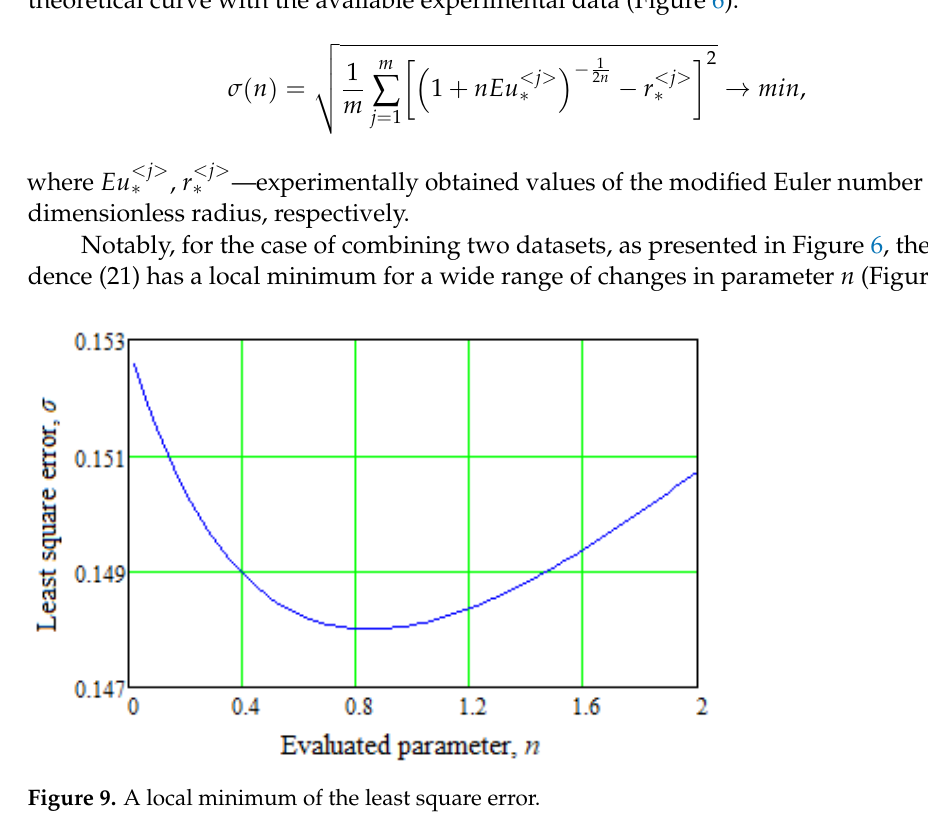
Figure 8. Dependence of the initial bubble boiling point radius on the relative initial underheating.